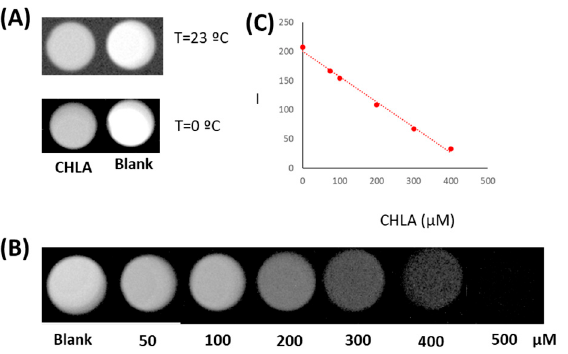
Figure 5. ( A ) Effect of the CCD camera temperature on the chemiluminiscent image (CHLA 100 μ M), ( B ) Variation of the chemiluminiscent intensity over CHLA concentration, and ( C ) Correlation of the CL intensity as a function of CHLA concentration.